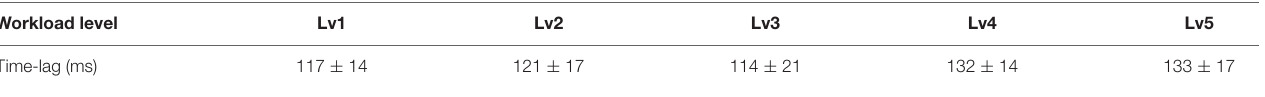
TABLE 1 | Group-average time-lag (mean ± SD) between bF θ and rPO α 2 estimated with dSTE NG for each cognitive workload level (CWL) based on correct trials. Workload level